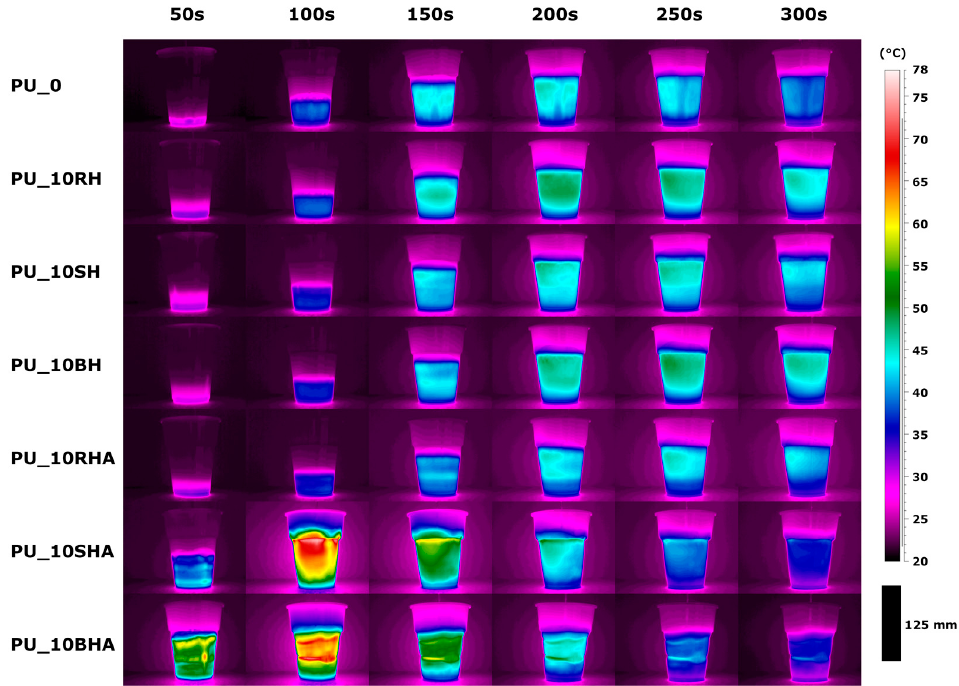
Figure 6. Photographs of all samples during the RPUFs’ synthesis at selected times.